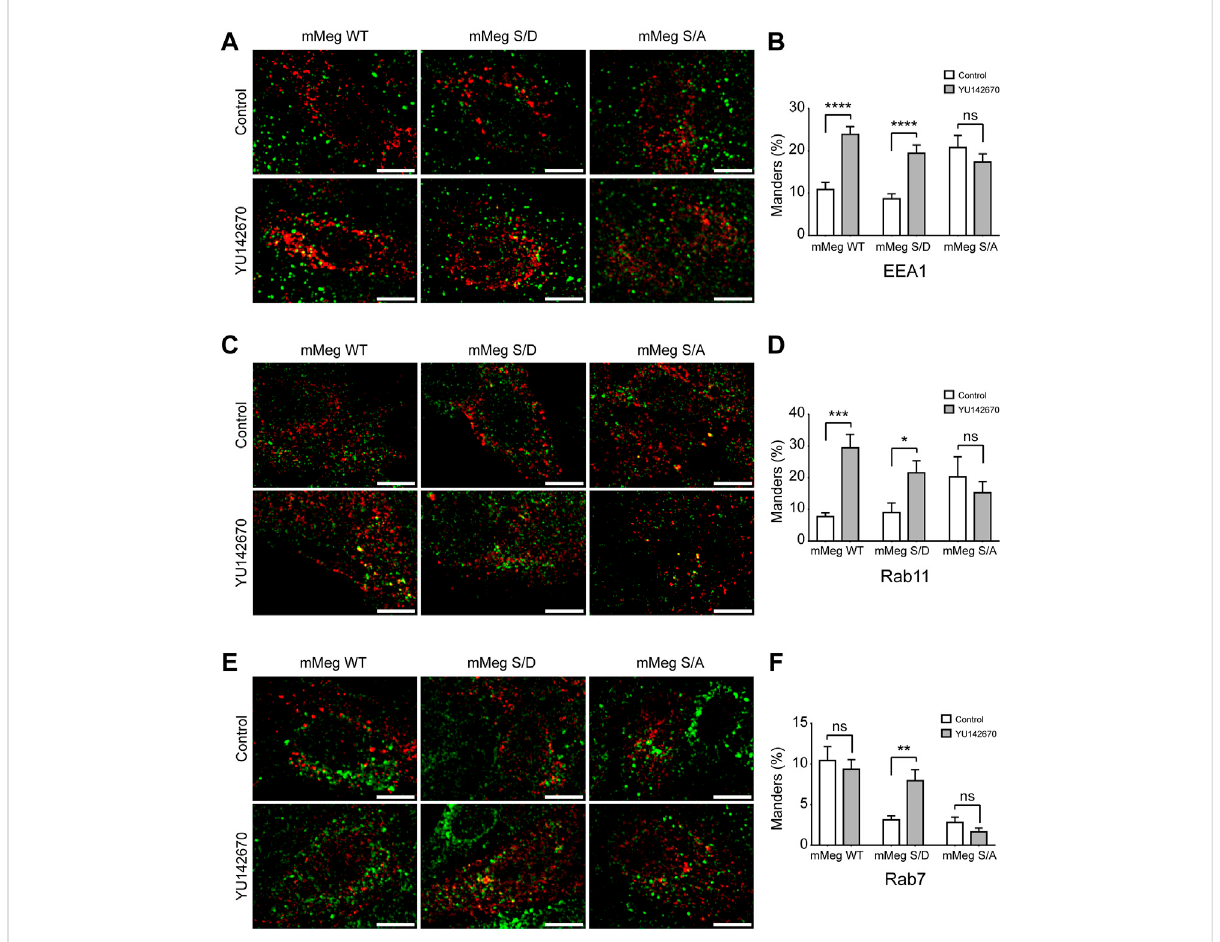
FIGURE 5 Endosomal distribution of megalin and its phosphorylated and non-phosphorylated forms in control and OCRL inhibition conditions. LLC-PK1 were transfected with HA-tagged minimegalins (mMeg) wt, phosphomimetic (mMeg S/D) or non-phosphorylatable mMeg S/A. Then, cells were treated with 50 μ M YU142670 or vehicle for 4 h, fi xed and processed for fl uorescence microscopy. Preparations were imaged with Confocal Nikon Timelapse. Scale Bars 10 μ M. (A) Cells were stained with anti-EEA1 (green) and anti-HA (red). (B) At least 34 separated cells were analyzed with ImageJtomeasuretheManderspercentagebetweenEEA1endosomesandHA-taggedmMegstructures.ANOVA,**** p < 0.0001. (C) LLC-PK1 cells were co-transfected with mCherry-Rab11 and HA-tagged mMeg. Then, cells were treated with 50 μ M YU142670 for 4 h, fi xed and processed to detectmMeg (HA,red)andRab11(green).The colorwaschanged forconsistency withtheotherpanels. (D) At least12 separated cellswereanalyzed with ImageJ to measure the Manders percentage between Rab11-positive endosomes and mMeg structures. ANOVA, *** p < 0.001, * p < 0.05. (E) LLC-PK1 transfected with HA-tagged mMeg. Then, cells were treated with 50 μ M YU142670 for 4 h, fi xed and processed to detect mMeg (HA, red) and Rab7 (green). (F) At least 18 separated cells were analyzed with ImageJ to measure the Manders percentage between Rab7-positive endosomes and mMeg structures. ANOVA, ** p <